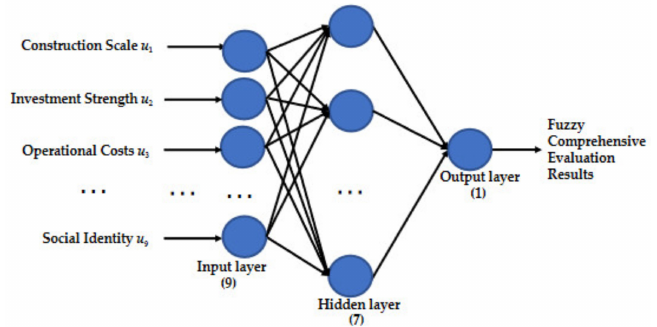
Figure 4. Architecture of artificial neural network for HRSs site